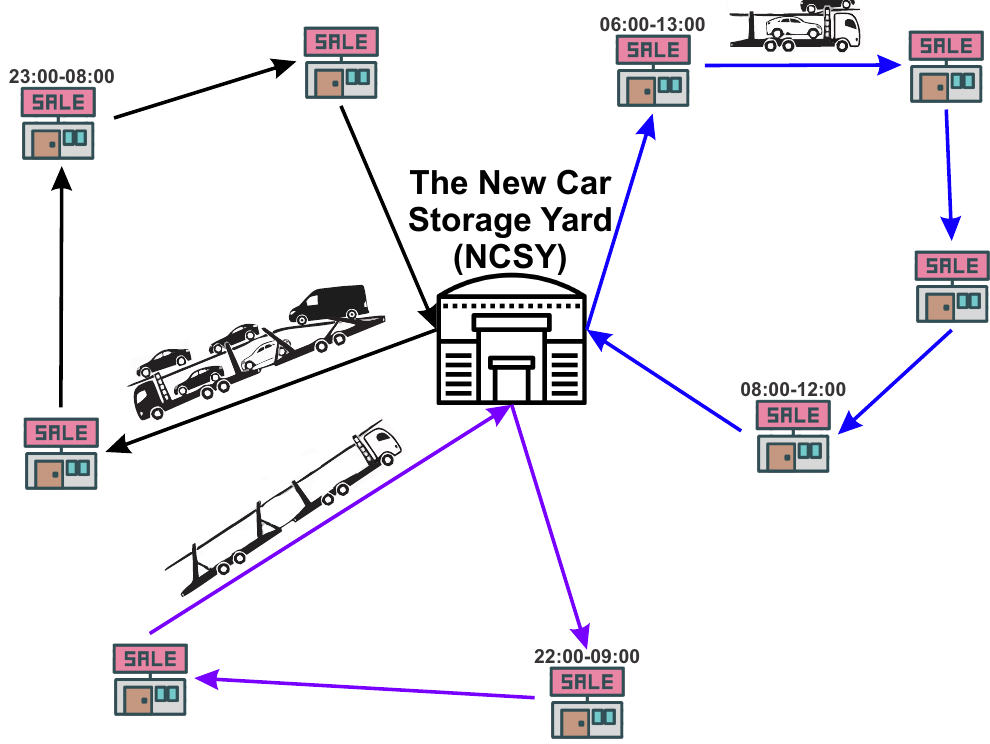
Figure 1. An illustration for the proposed problem by a logistics